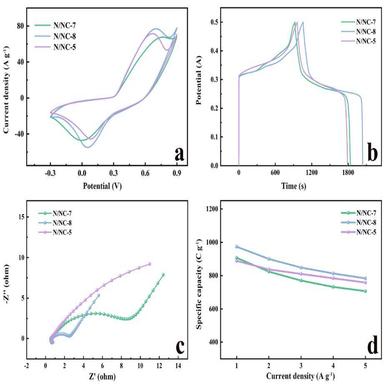
The electrochemical properties of N/NC-7, N/NC-8, and N/NC-5. CV curves at 30 mV s − 1 (a), GCD curves at 1 A g− 1 (b), the Nyquist plots of impedance data (c) and specific capacity at various current densities from 1 A g− 1 to 5 A g− 1 (d).